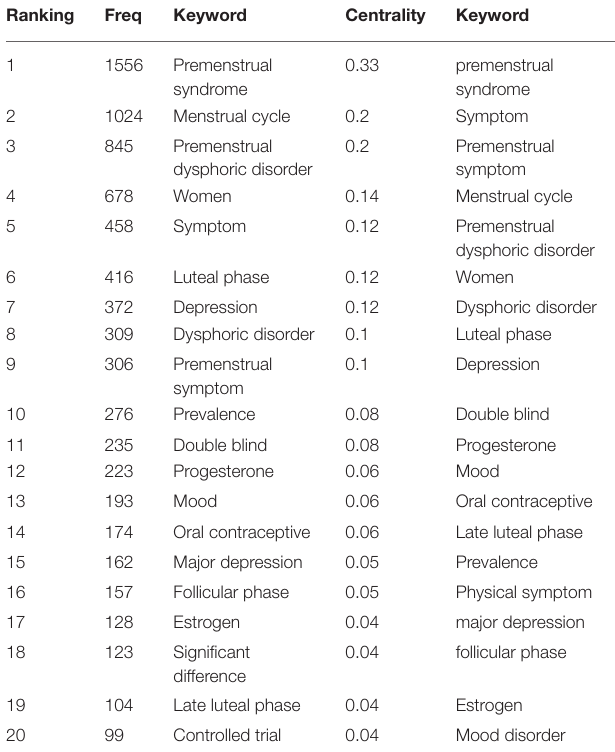
TABLE 6 | Top 20 keywords in terms of frequency and centrality in PMS/PMDD research.